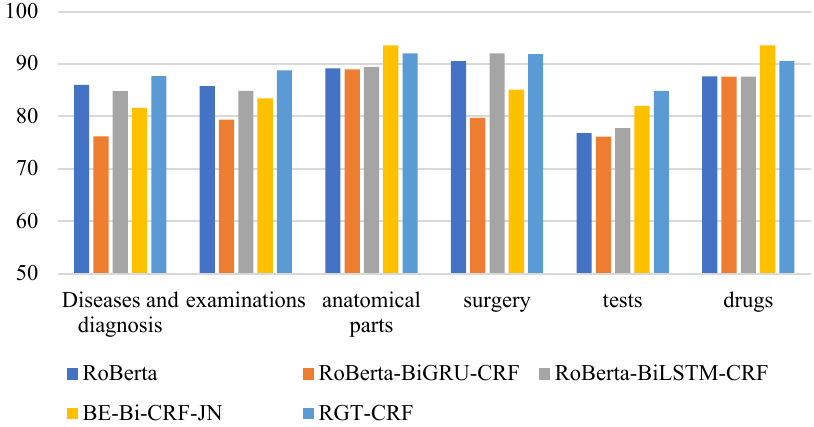
Figure 14. F1 values of different entities on CCKS2018 for different models.